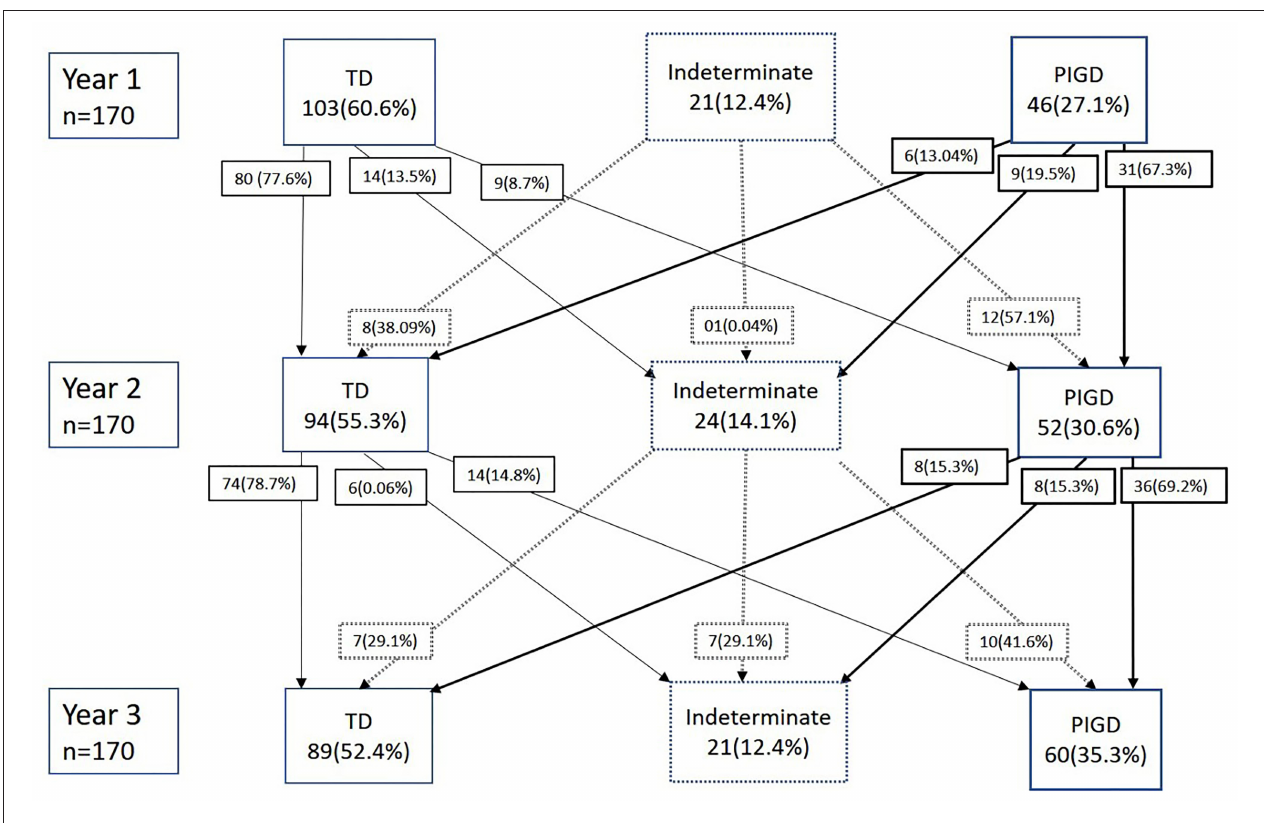
FIGURE 1 | Shifts in Parkinson’s disease (PD) subtypes over 3 years.